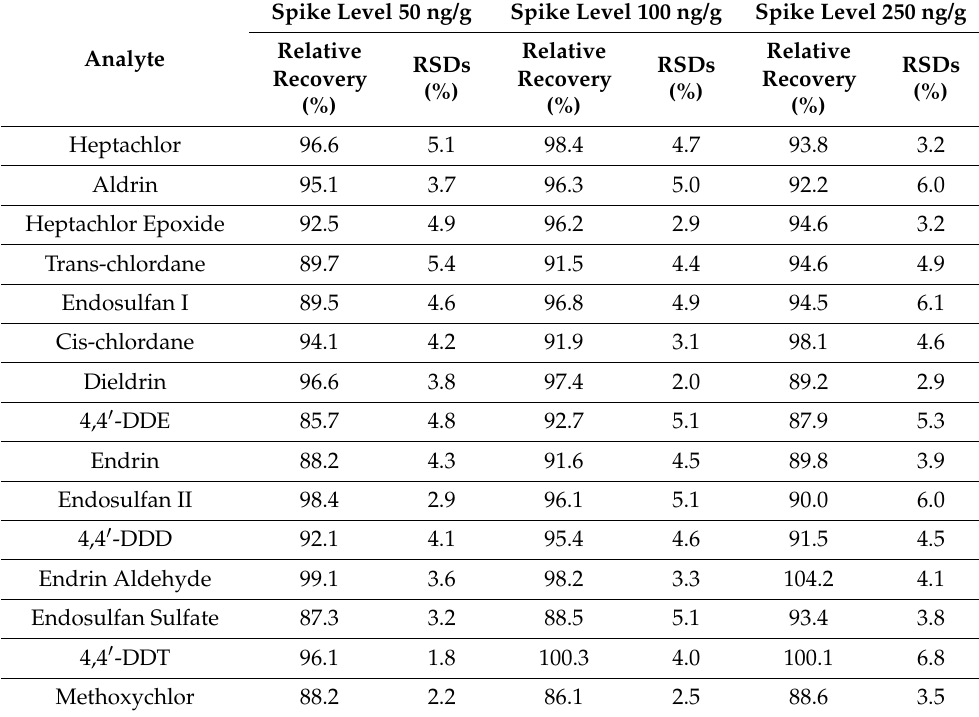
Table 5. Relative recoveries of OCPs after spiking pooled dried fish samples (n = 3).